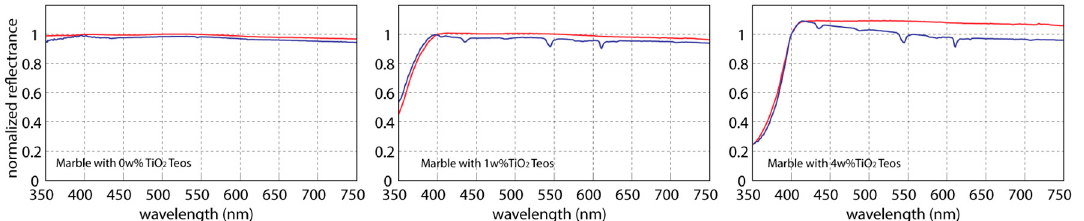
Figure 3. Comparison between average spectral signatures obtained by data collected on 31 March (blue lines) and 15 June (blue lines) 2016. For each signature, the reflectance values are normalized respect to that obtained at 400